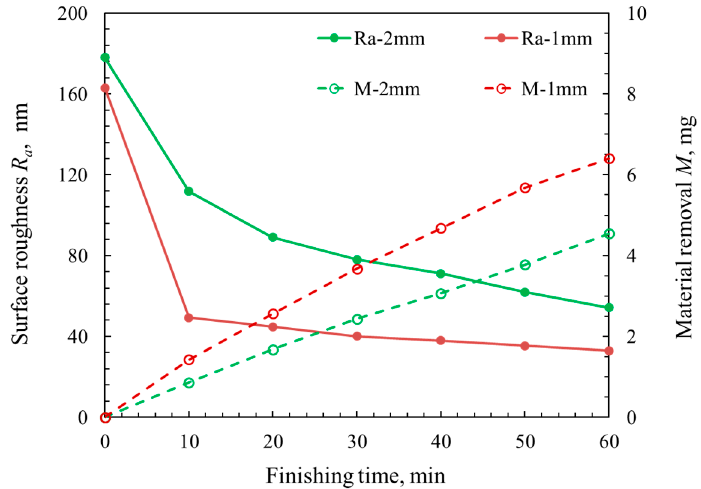
Figure 8. Change in surface roughness R a and material removal M under different working gaps in the 60-min MAF process.